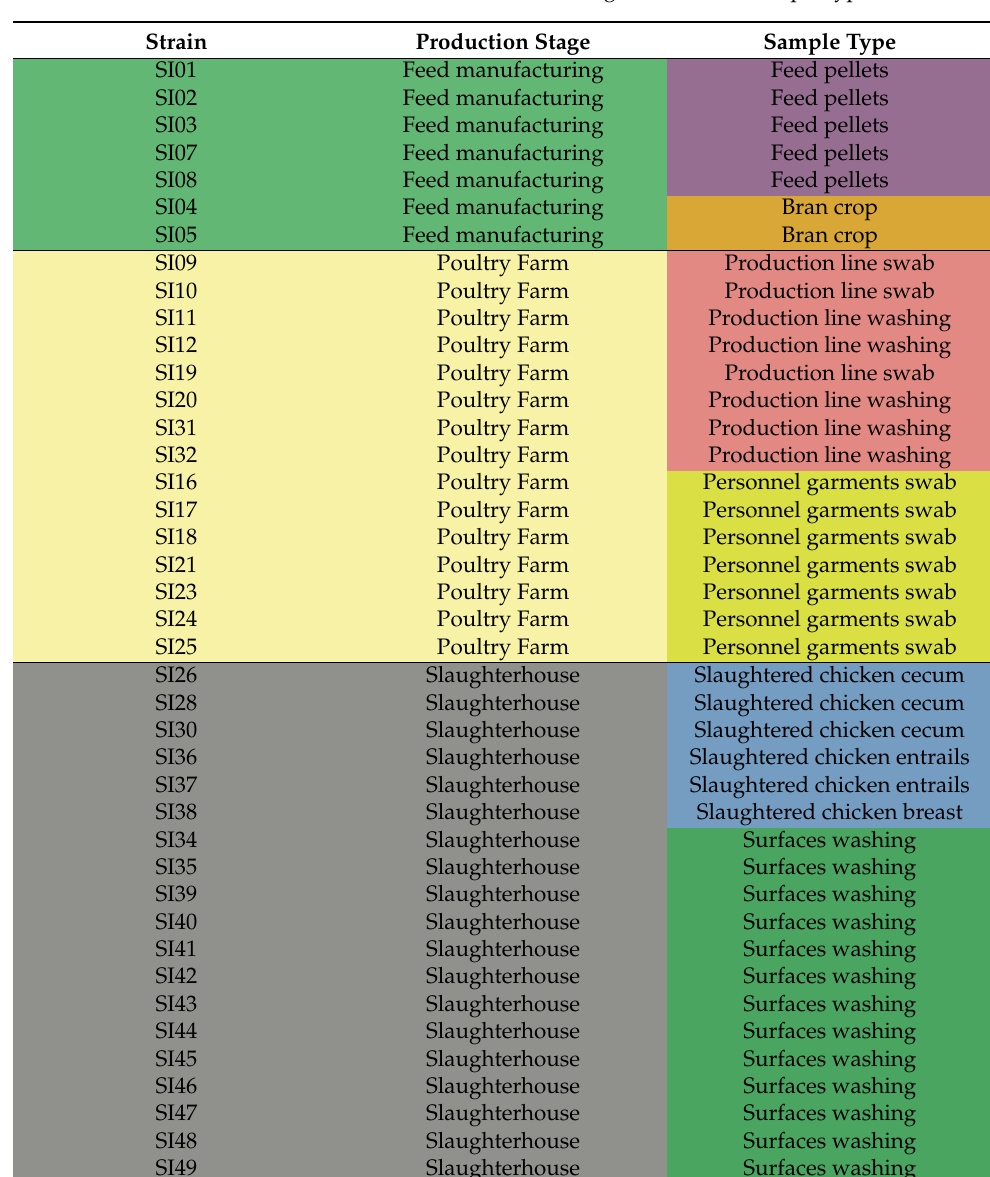
Table 1. The 41 Salmonella Infantis strains isolated, indicating location and sample